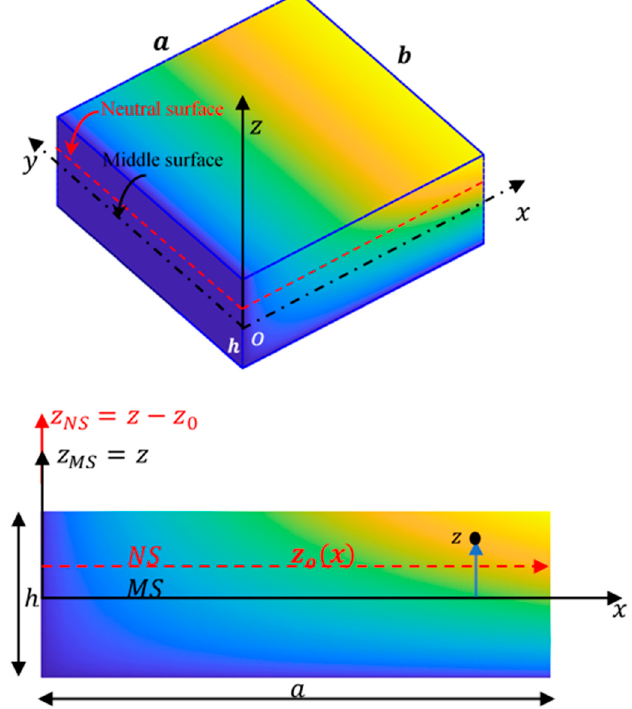
Figure 1. Plate geometry and references surfaces: MS and NS.